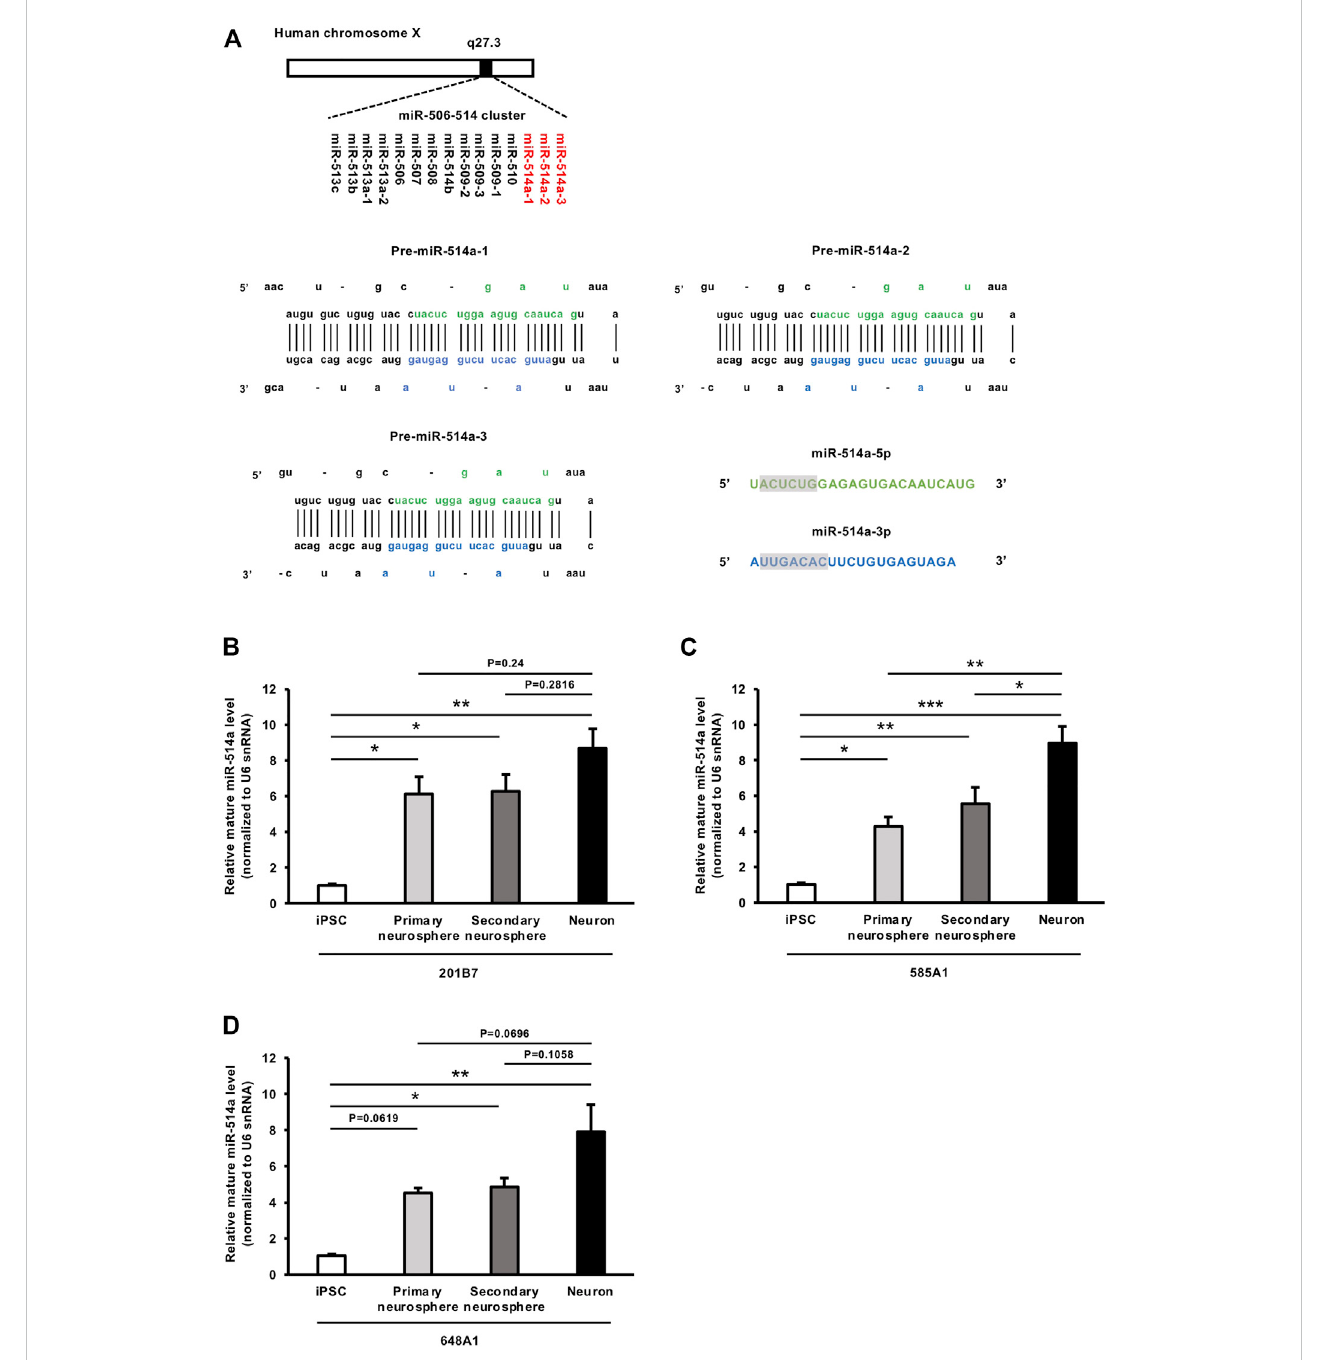
Genomic structure of miR-514a and its expression levels at each stage of neuronal differentiation. (A) Diagram of the structure of the human miR-514a locus and sequence of the precursor of miR-514a (pre-miR-514a). miR-514a belongs to the X-linked primate-speci fi c miR-506-514 cluster. Primary